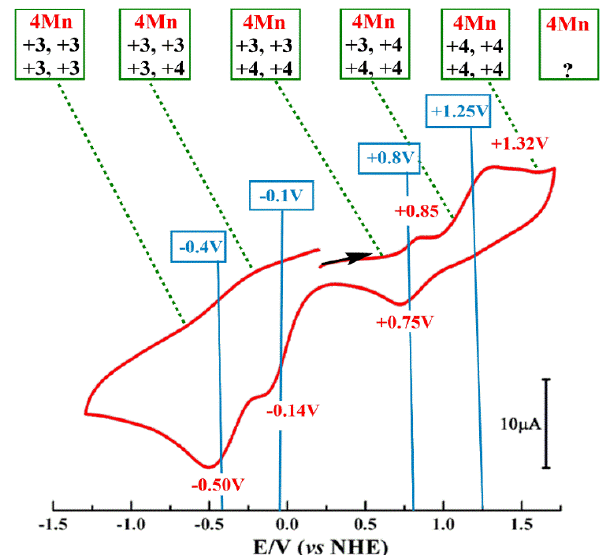
Figure 10. Cyclic voltammogram (CV) of the artificial Mn 4 CaO 4 -complex [118]. Peak positions of CV waves are in red and estimated midpoint potentials are in blue. The likely oxidation states of the four Mn ions in various oxidation states of artificial complex are indicated using black numbers.